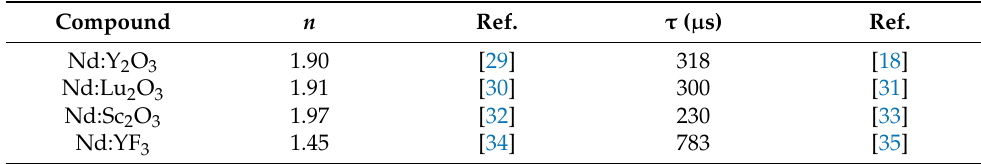
Table 1. Parameters used for cross-section calculation.